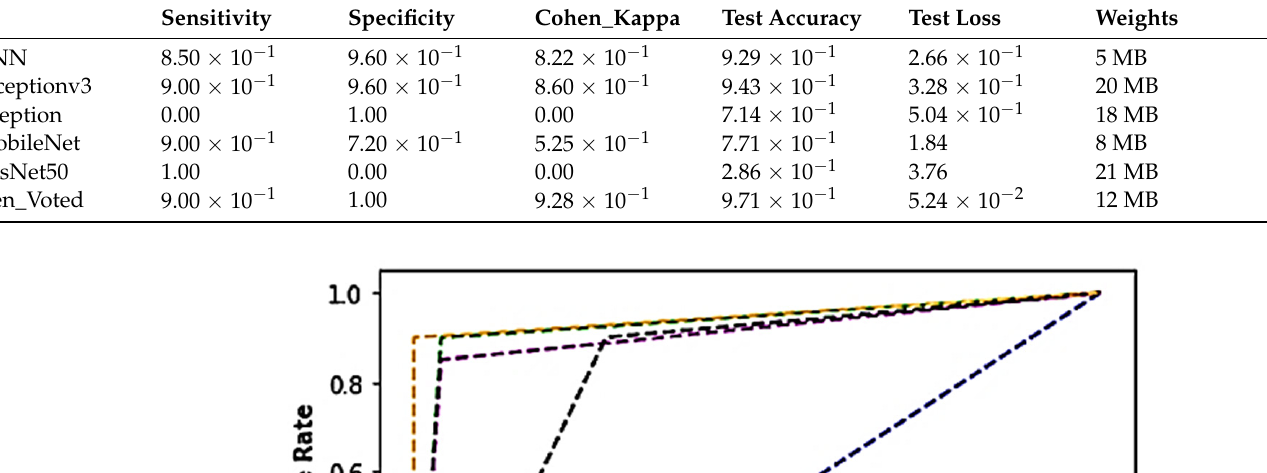
Table 2. Results achieved from the various learners with the industrial AC Piston dataset.